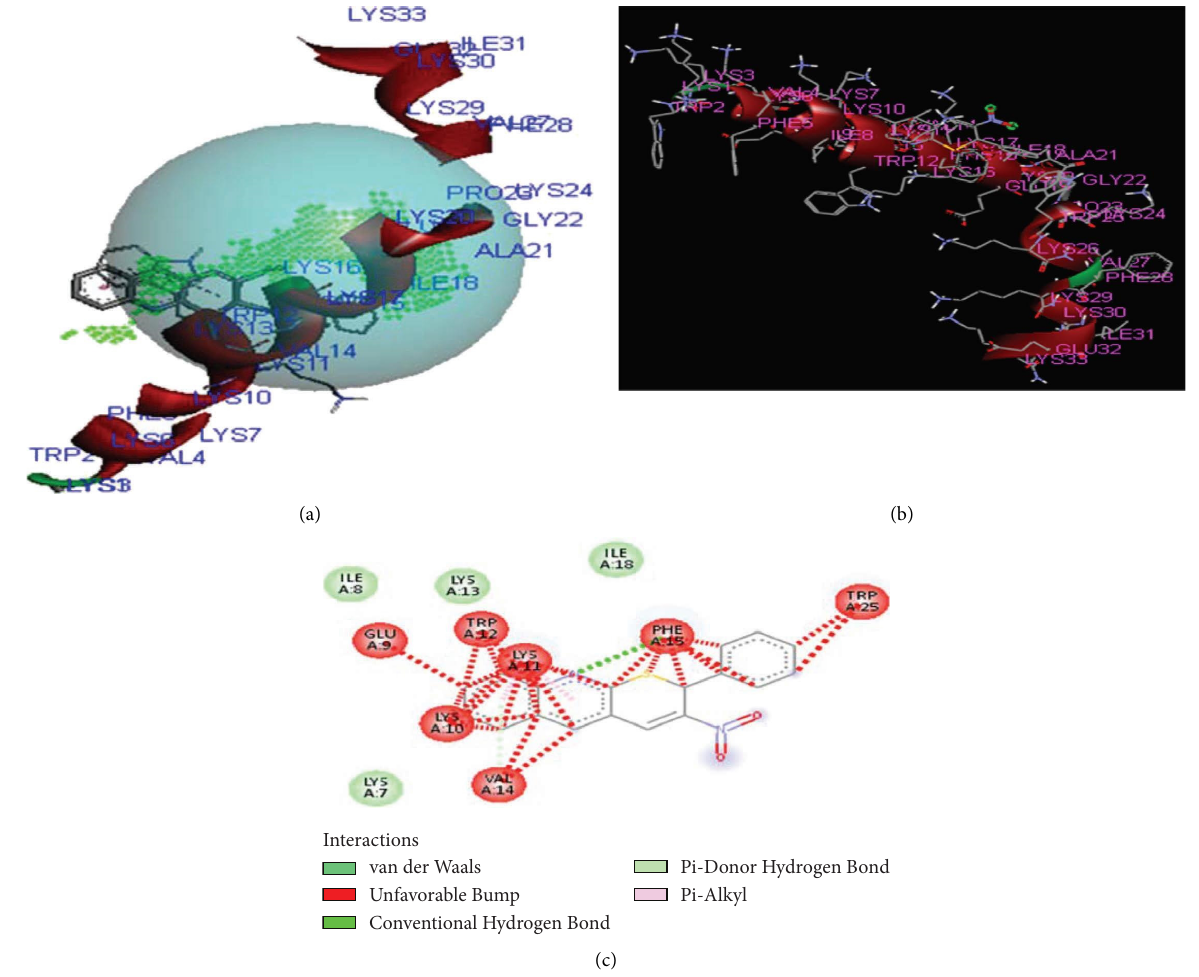
Figure 5: Te binding interaction of 3-nitro-2-phenyl-2 H -thiopyrano[2,3- b ]quinoline ( 3 ) against CB1a ( PDB ID: 2IGR ) (a) receptor cavities present during interaction, (b) interaction of protein and ligand, and (c)